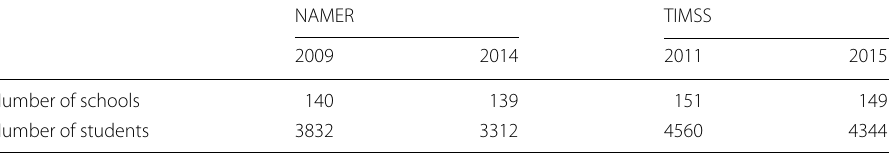
Table 1 Sample sizes in NAMER 2009, 2014 and TIMSS 2011, 2015 in